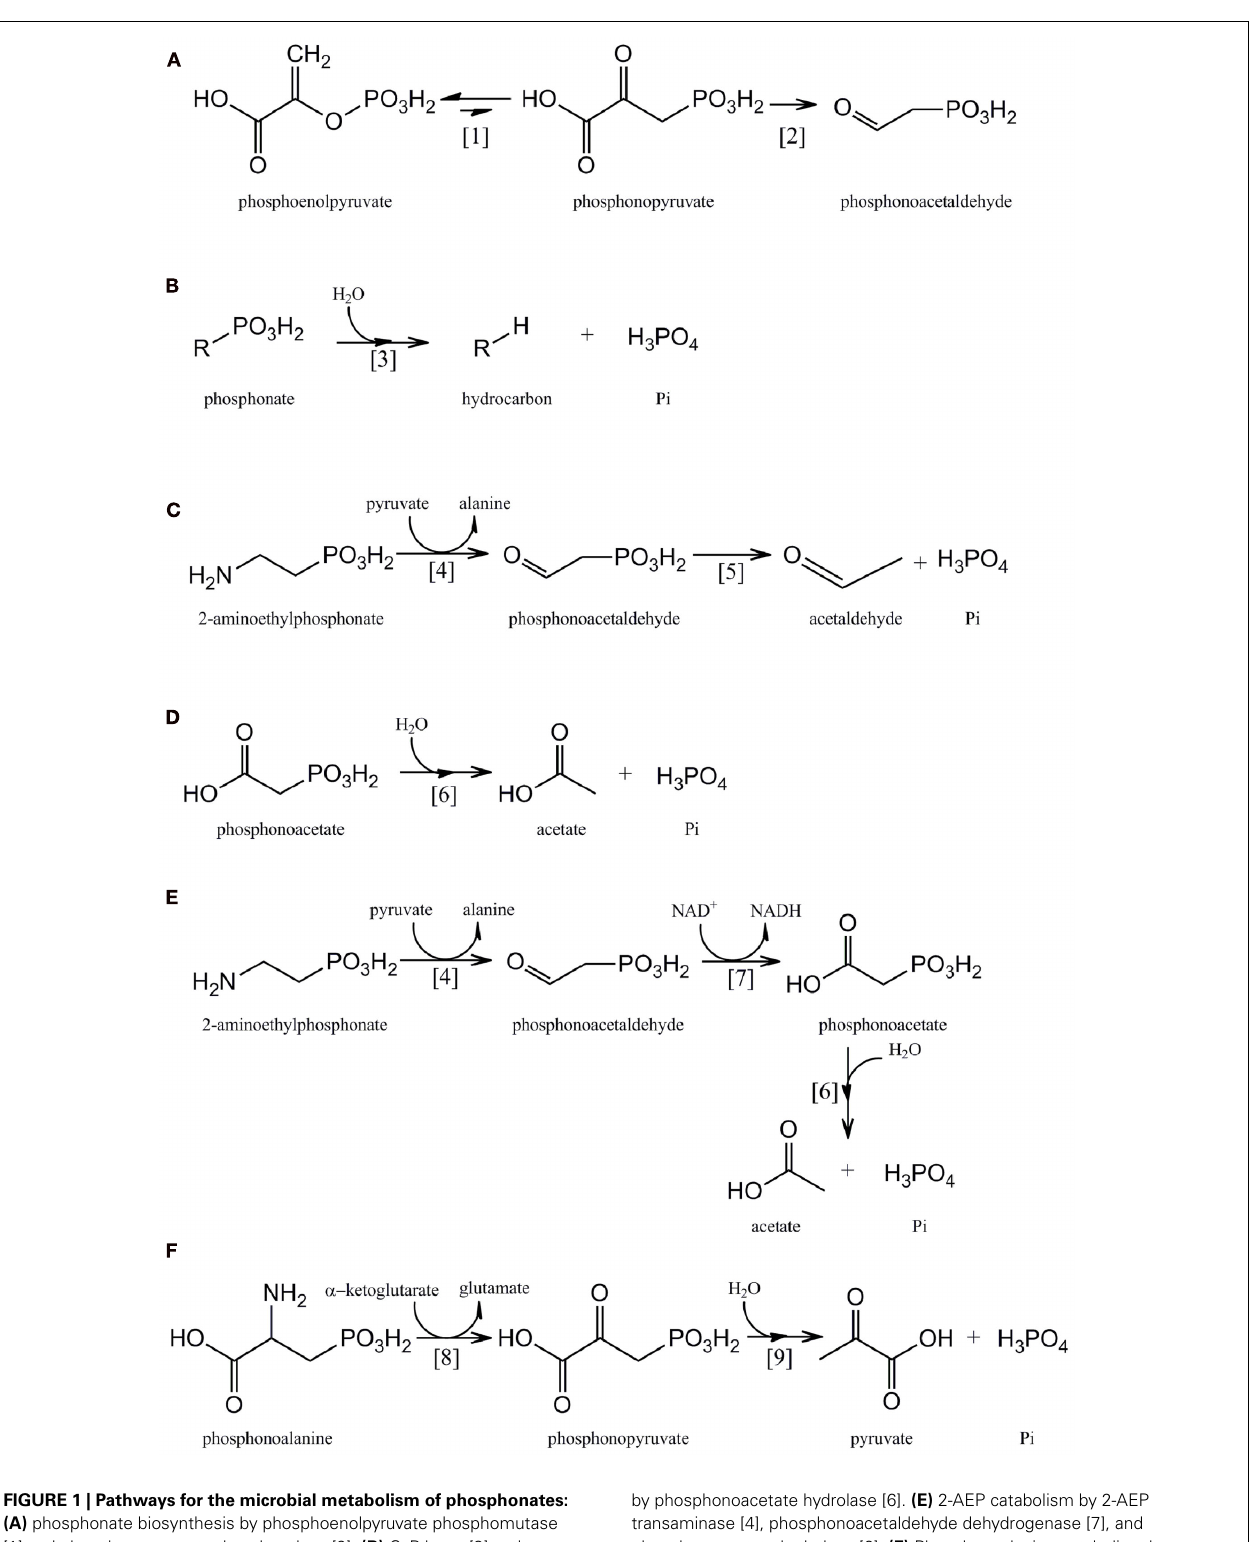
by phosphonoacetate hydrolase [6]. (E) 2-AEP catabolism by 2-AEP transaminase [4], phosphonoacetaldehyde dehydrogenase [7], and phosphonoacetate hydrolase [6]. (F) Phosphonoalanine catabolism by a phosphonoalanine transaminase [8] and phosphonopyruvate hydrolase